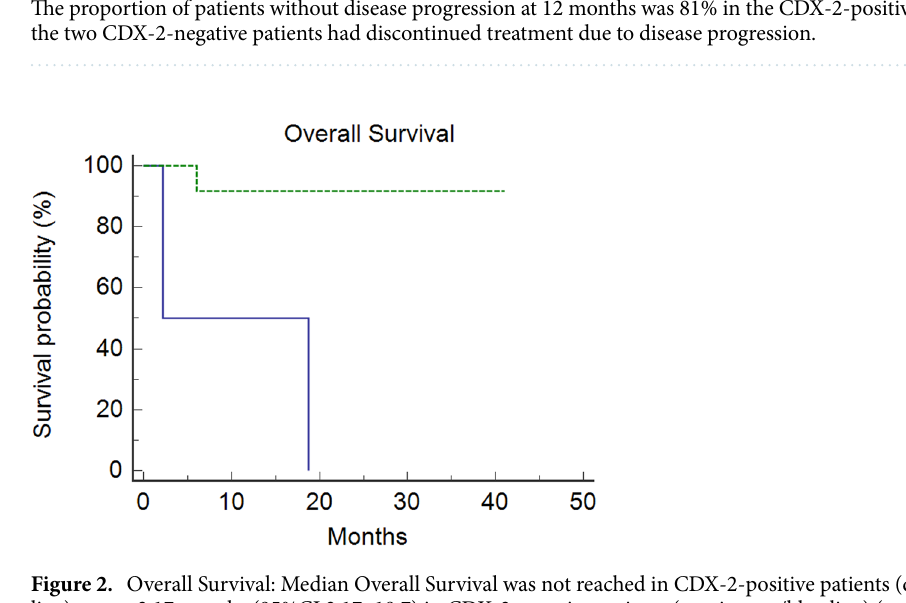
Figure 2. Overall Survival: Median Overall Survival was not reached in CDX-2-positive patients (dotted/green line) versus 2.17 months (95%CI 2.17–18.7) in CDX-2-negative patients (continuous/blue line) ( p = 0.026).